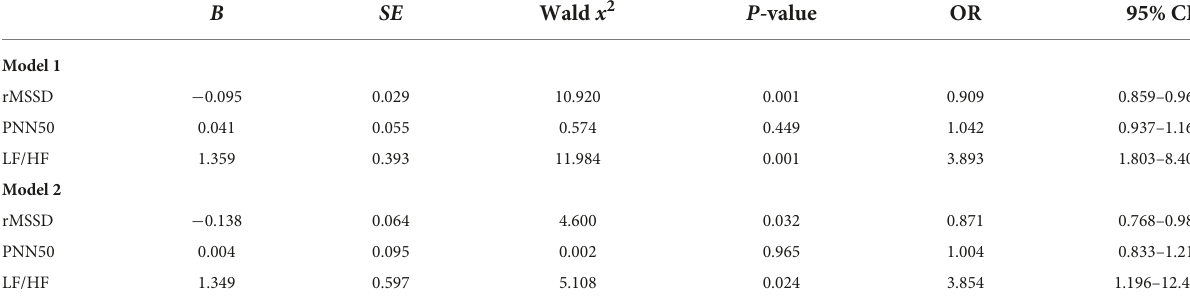
TABLE 2 Heart rate variability (HRV) in relation to BG-EPVS load (binary logistic